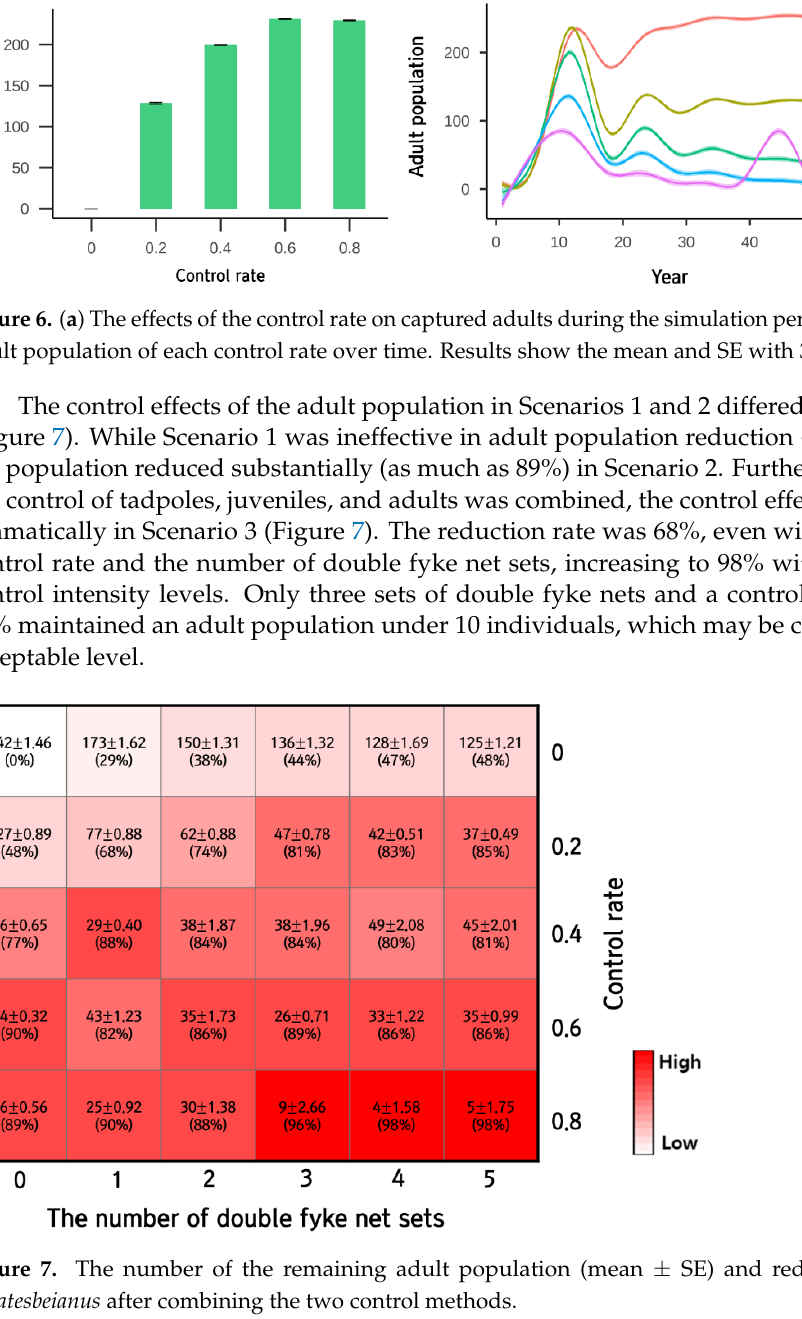
Figure 5. ( a ) The effect of the number of double fyke net sets on captured tadpoles during the sim- ulation period and ( b ) adult population. Results show the mean and SE with 30 replicates.